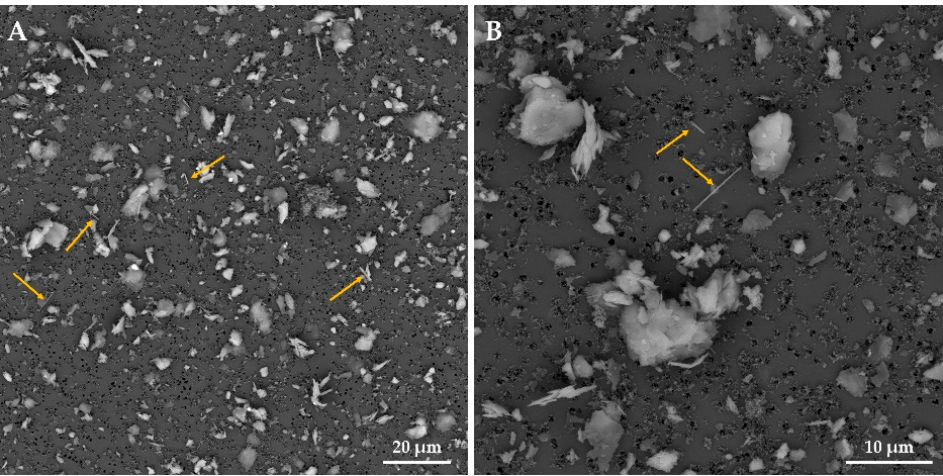
Figure 7. Overview of the reading field of airborne sampling from shales at 2000× ( A ) and 5000× ( B ). Scale bar in microphotographs; High Vacuum: 20 kV; Detector: Back Scattered Electrons.